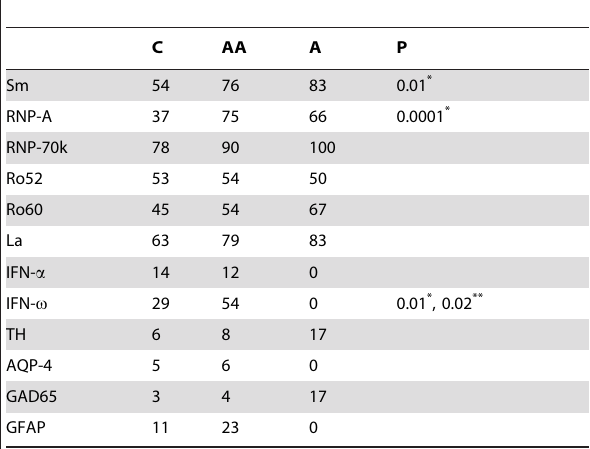
Table 6. Percentage of seropositive patients by age